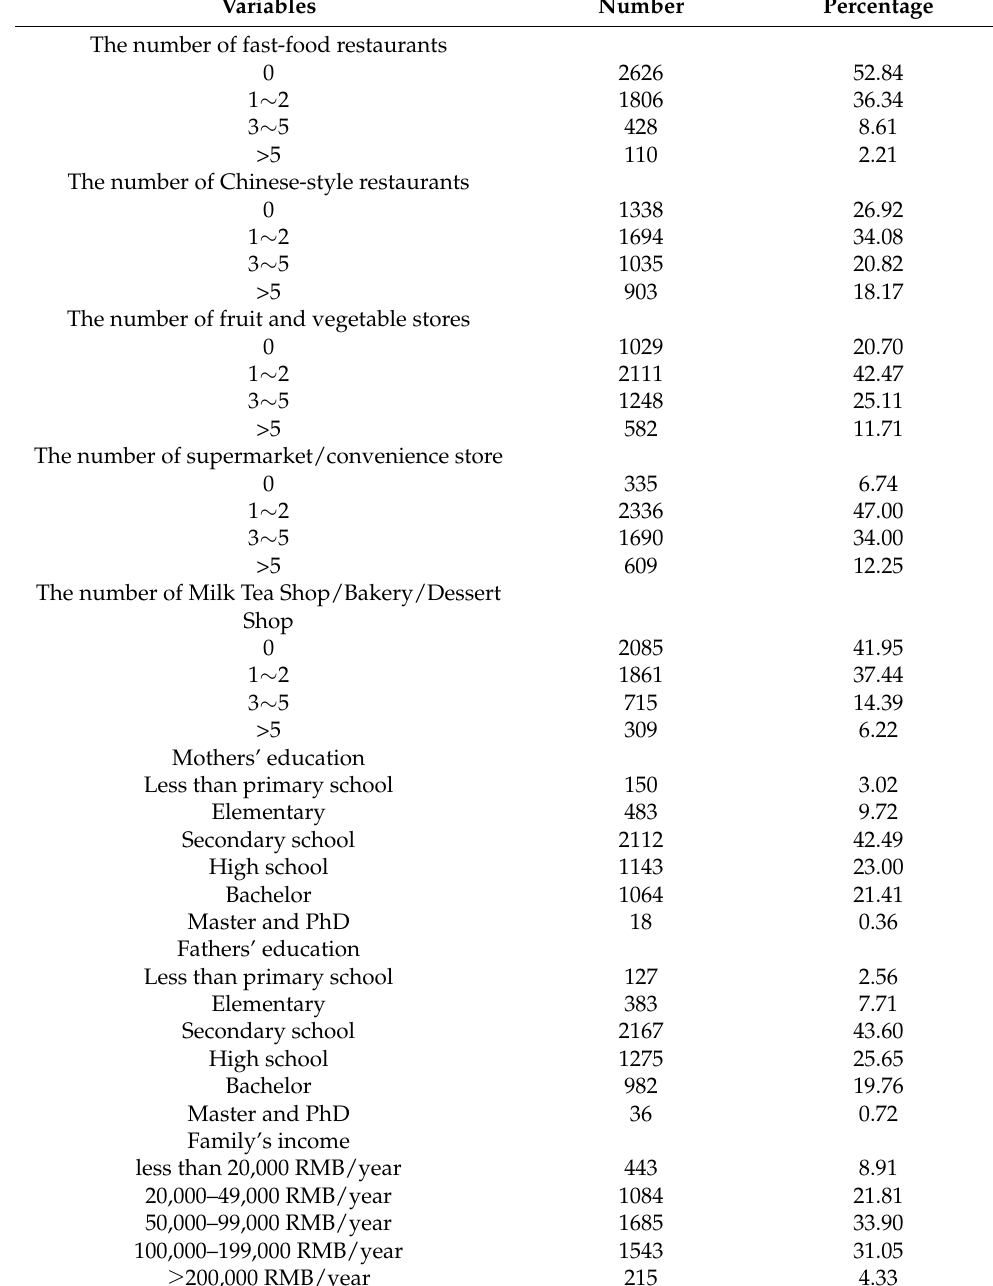
Table A2. The descriptive statistics of the latent variables